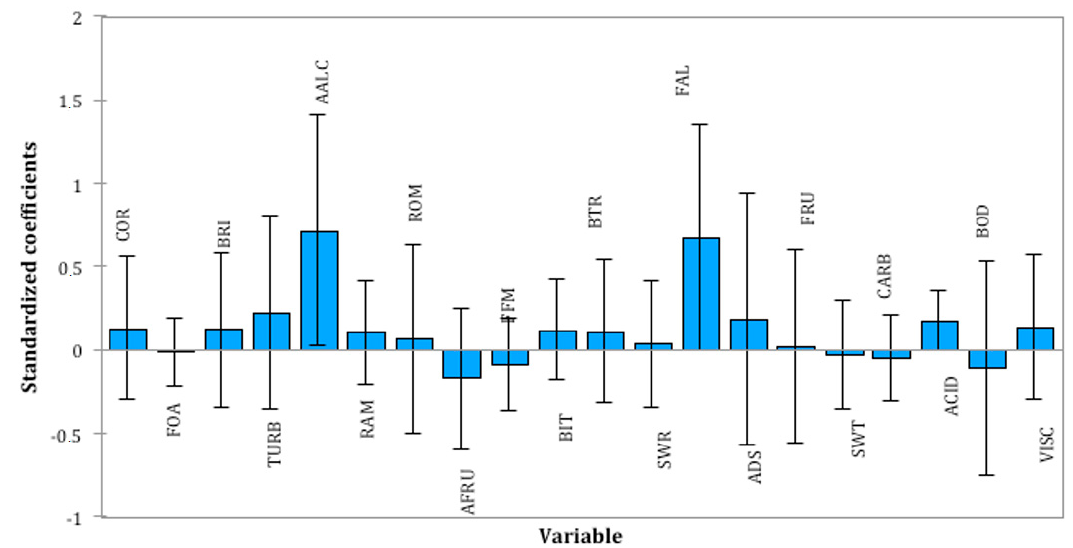
Figure 1. Preference drivers for partial least squares regression analysis. Abreviations = Yellow Color (COR); Foam Presence (FOA); Brightness (BRI); Turibidity (TURB); Alcoholich Aroma (AALC); Raw Malt Aroma(RAM); Roasted Malt Aroma (ROM); Fruity Aroma(AFRU); Malt Flavor (FFM); Bitter Taste (BIT); Bitter Residual (BTR); Sweet Residual (SWR); Alcoholic Flavor (FAL); Adstringent (ADS); Fruity Flavor (FRU); Sweet Taste (SWT); Acidity (ACID); Viscosity (VISC) Carbonation (CARB); Body (BOD).